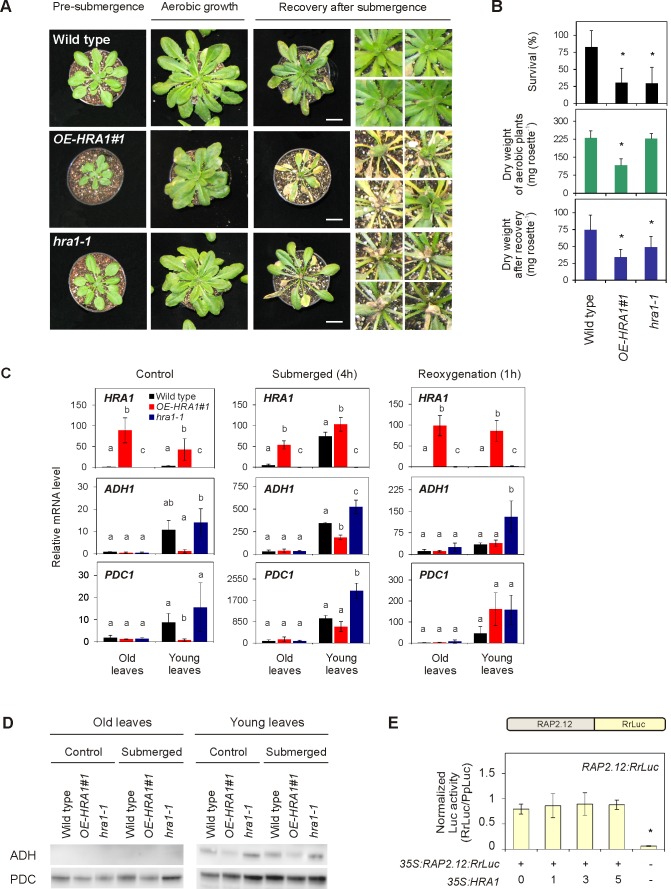
HRA1 contributes to plant submergence survival.(A) Effect of HRA1 misexpression on rosette growth in air, or after recovery from 72 h submergence in darkness. Scale bar, 2 cm. (B) Percentage of plants surviving flooding-induced hypoxia (n = 5), dry weight of rosette plants kept under control growth conditions (n = 6), and dry weight of rosettes after postsubmergence recovery (n = 6). Data are mean ± s.d.; *p<0.05, significant differences from the wild type after one-way ANOVA. (C) HRA1 regulates target gene transcripts in an age-dependent manner in leaves of plants treated with complete submergence. Transcripts were measured before submergence (“control conditions”), after 4 h submergence in darkness (“submergence”), and after 1 h de-submergence in the light (“reoxygenation”). Relative transcript values were calculated using old leaves of the wild type under control conditions as the reference sample. Data are mean ± s.d. (n = 3); letters indicate statistically significant differences between genotypes after one-way ANOVA (p<0.05) performed independently on each leaf type. (D) Western blot analysis of ADH and PDC protein accumulation in leaves at different developmental stages from control and submerged (4 h) plants. The full-size images of the hybridized membranes can be found in Figure S10. (E) Stability of the translational fusion RAP2.12:RrLuc protein (RrLuc, Renilla reniformis luciferase) in Arabidopsis mesophyll protoplasts upon transfection with increasing amounts of 35S:HRA1. RAP2.12:RrLuc abundance was evaluated from the RrLuc relative activity, measured through a dual luciferase assay. Data are mean ± s.d. (n = 4), and the asterisks indicate statistically significant differences (p<0.05) from protoplasts expressing RAP2.12:RrLuc alone, after one-way ANOVA.